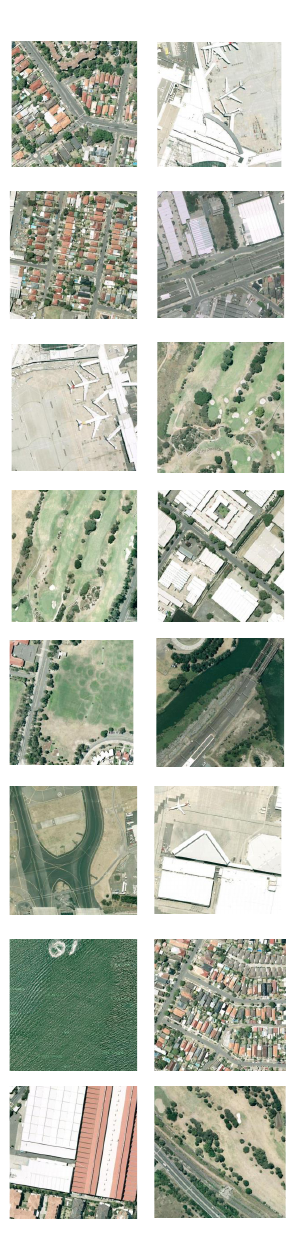
Figure 6. Some images and two image-captioning pairs in Sydney data